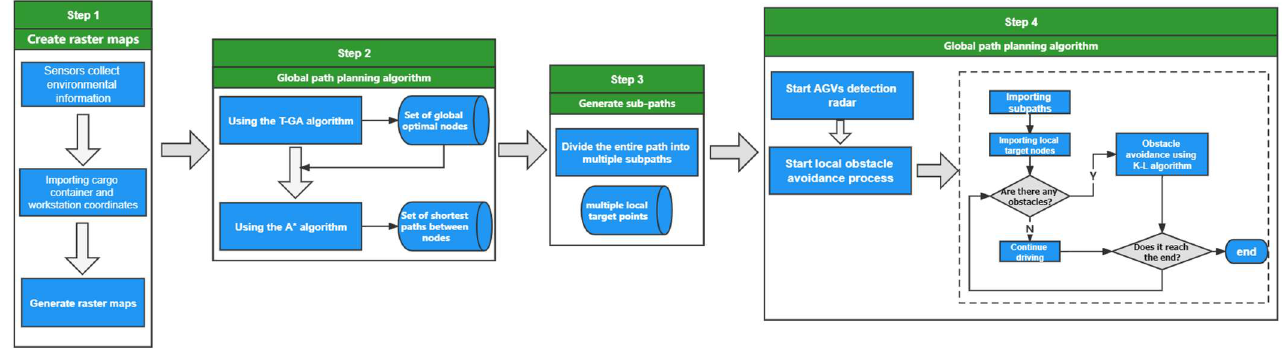
Figure 5. Flow chart of the GA-KL method.